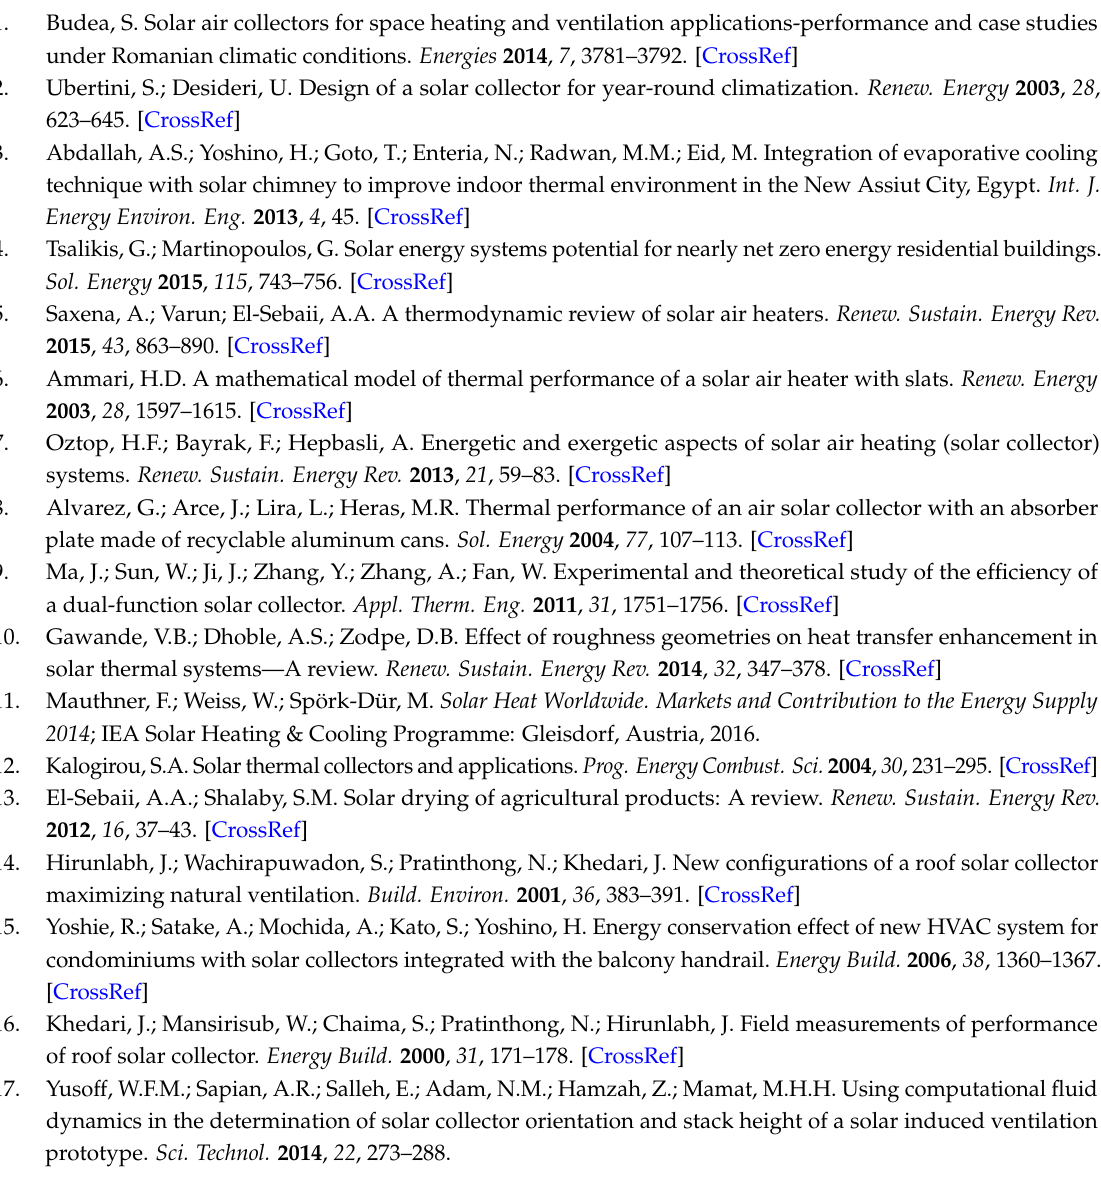
Figure 5. Curves of efficiency for the different airflows